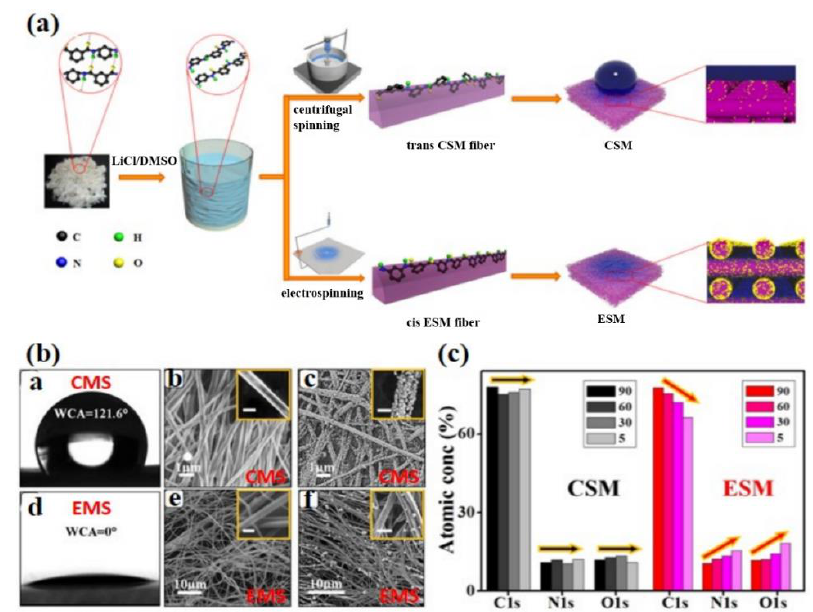
Figure 13. ( a ) Schematic illustration of the formation of the cis-PMIA ESM; ( b ) Static contact angles of water droplets on the PMIA CSM and PMIA ESM and representative SEM images of nanofibers on the PMIA CSM/Pt and PMIA ESM at Pt precursor concentrations of 0.01 M; and ( c ) ARXPS spectra of the CSM and ESM at different test depths. (Adapted from [116] with permission; Copyright 2017 ACS).